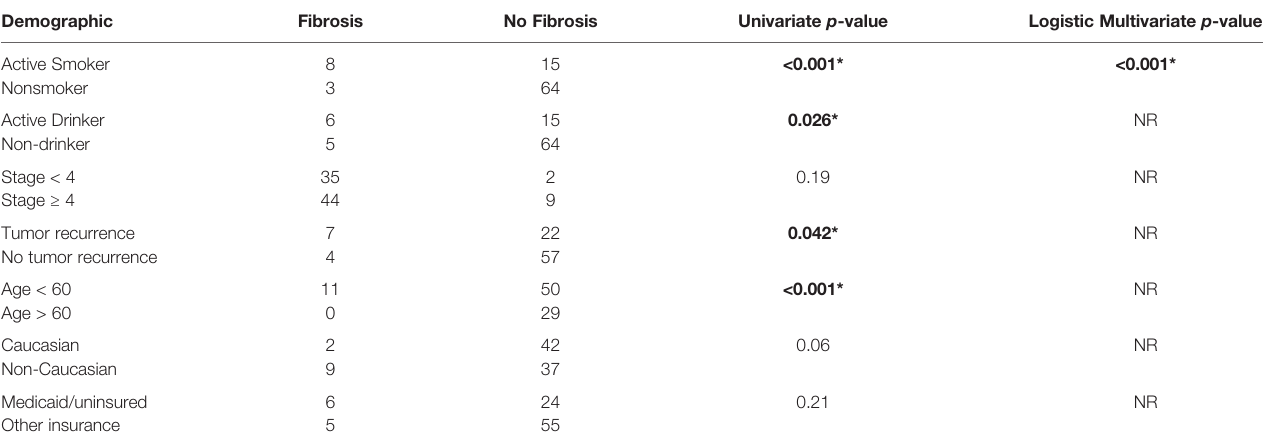
TABLE 2 | Demographics present during treatment contributed to incidence of fi